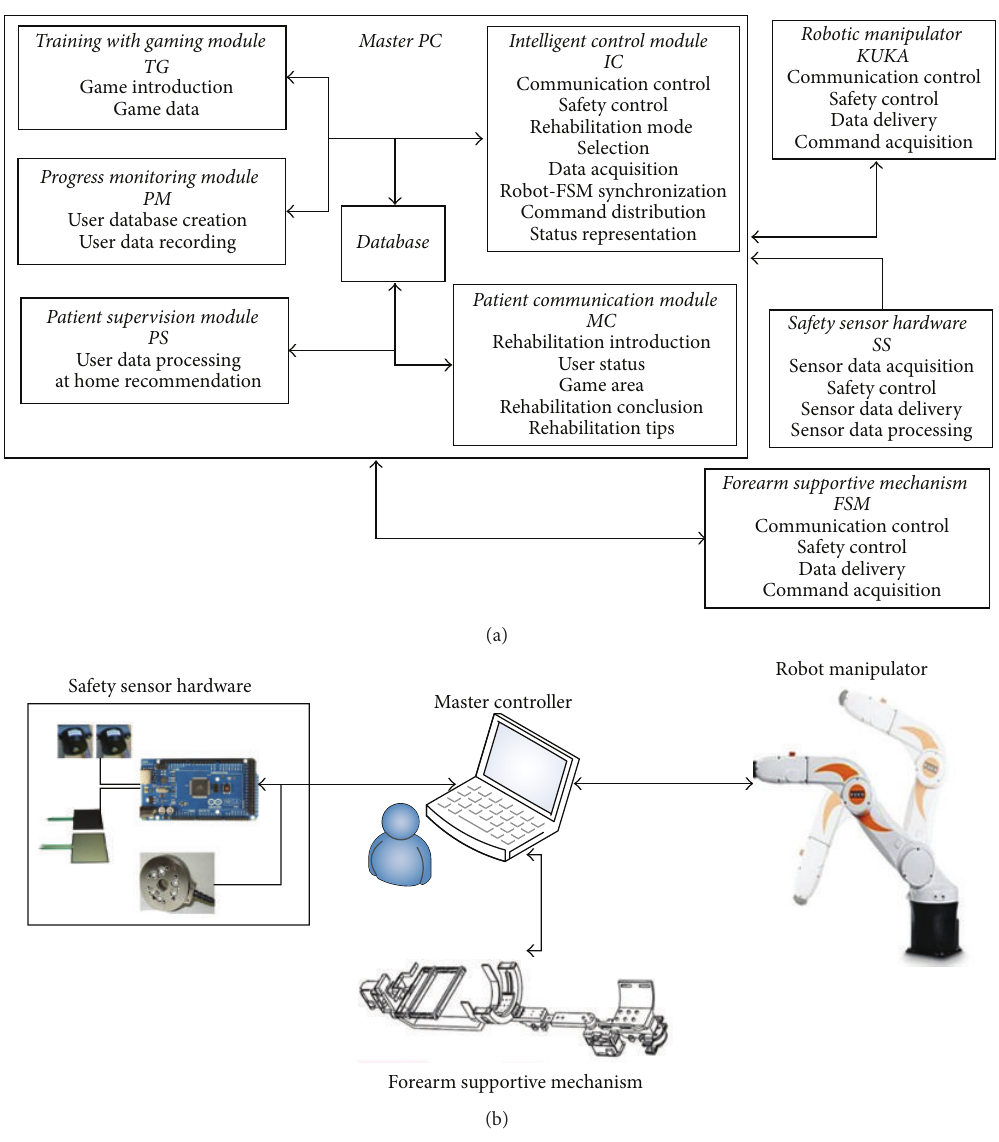
Figure 3: Overview of control system for SEFRE Rehab System: (a) scheme and (b)